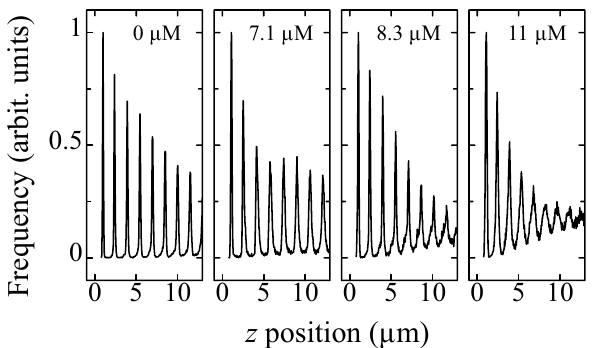
Figure 2. Histogram of the z position of the particles after 2-h sedimentation at the PSS concentration of 0.0, 7.1, 8.3, and 11 µ